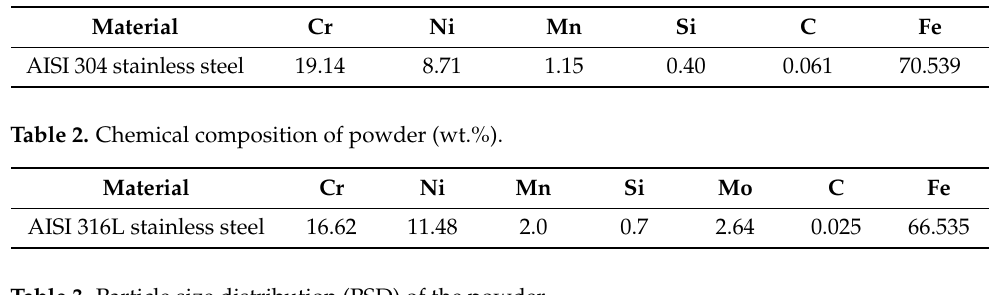
Table 3. Particle size distribution (PSD) of the powder.